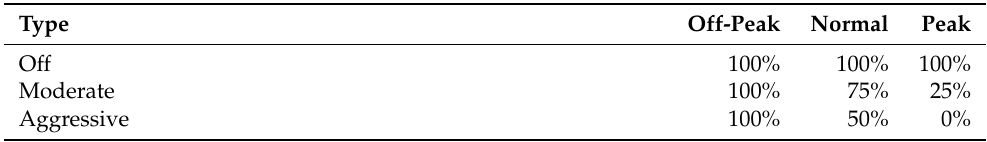
Table 2. An example of users’ Internet profile stating how much bandwidth they want to utilize during various congestion levels.